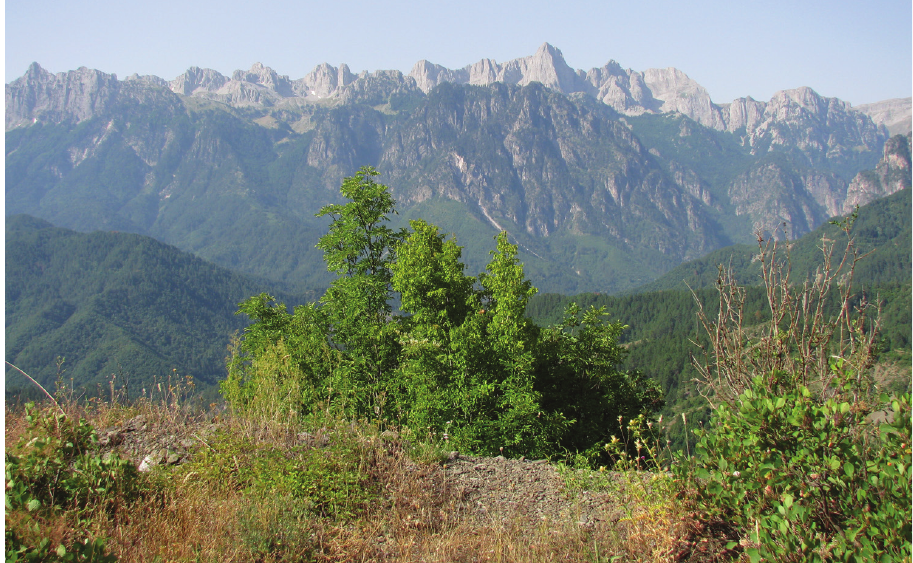
Figure 25. Habitat of P. admetus . Greece, Smolikas Mt, Konitsa, 950 m, 22 July 2008. Photo by V.A.